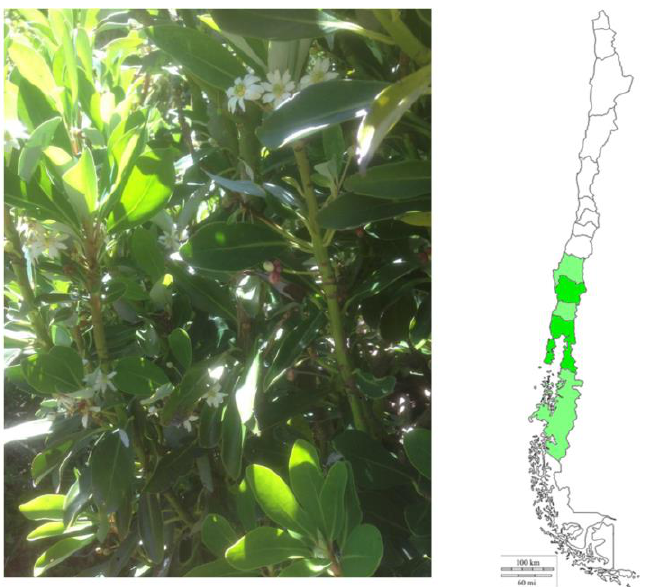
Figure 1. Picture of O. pillopillo collected at parque Oncol, Valdivia in November 2018 and zone of distribution in Chile.